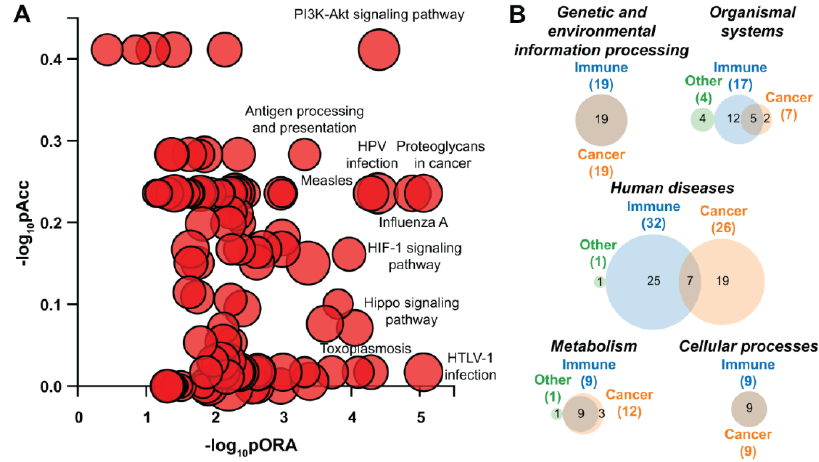
Figure 5. Pathways perturbation vs. over-representation and Venn diagrams in U87 glioblastoma cells overexpressing ZNF554 . ( A ) Pathways (the 10 most dysregulated ones are indicated) were plotted according to two types of evidence computed by iPathwayGuide: Over-representation on the x -axis (pORA) and the total pathway accumulation on the y -axis (pAcc). For both, measured p -values are displayed on the negative log (base 10) scale. ( B ) Dysregulated pathways in U87 cells transfected with ZNF554 were categorized in five Kyoto Encyclopedia of Genes and Genomes (KEGG) pathway subgroups. Venn diagrams show the overlap between immune- and cancer-related biological pathways in these subgroups. Akt serine/threonine kinase, Akt; hypoxia-inducible factor 1-alpha, HIF-1; human papillomavirus, HPV; human T-cell leukemia virus 1, HTLV-1; phosphatidylinositol 3-kinase, PI3K. Int. J. Mol. Sci. 2020 , 21 , x FOR PEER REVIEW